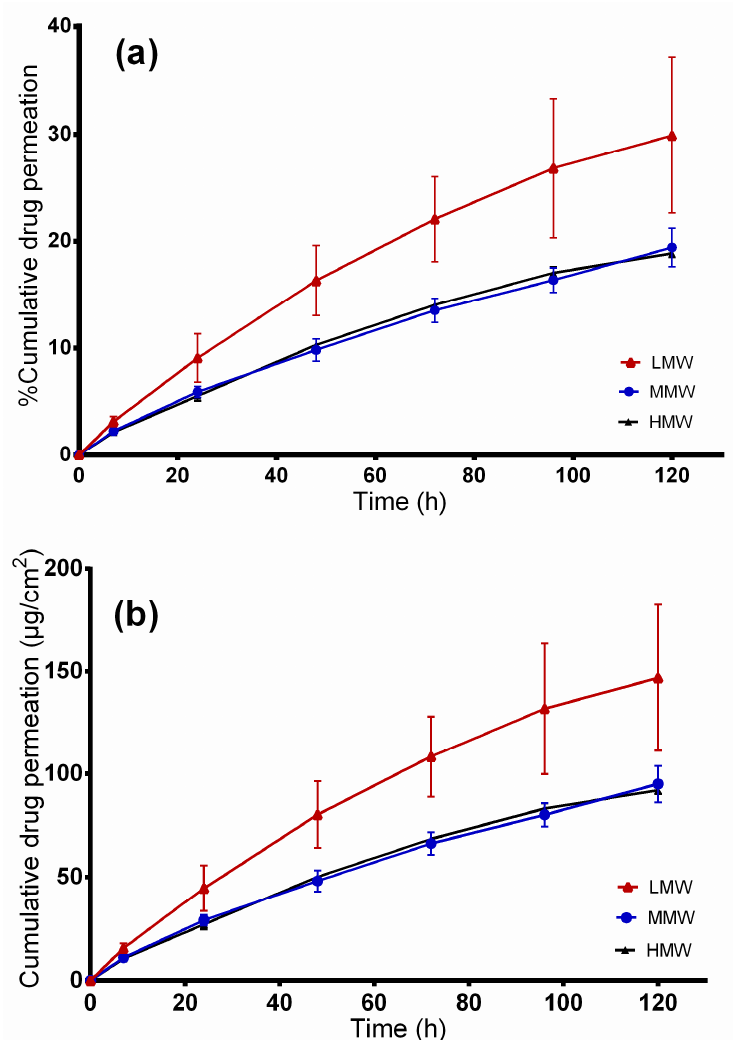
Figure 9. Ex vivo drug permeation studies. ( a ) Percentage of permeated betulin and ( b ) amount of betulin permeated from TE-loaded wound dressings.